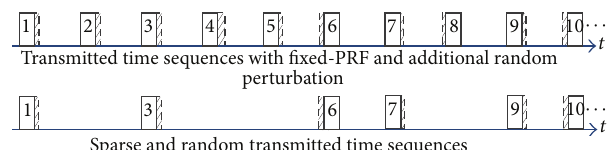
Figure 1: Illustration of radar dwell